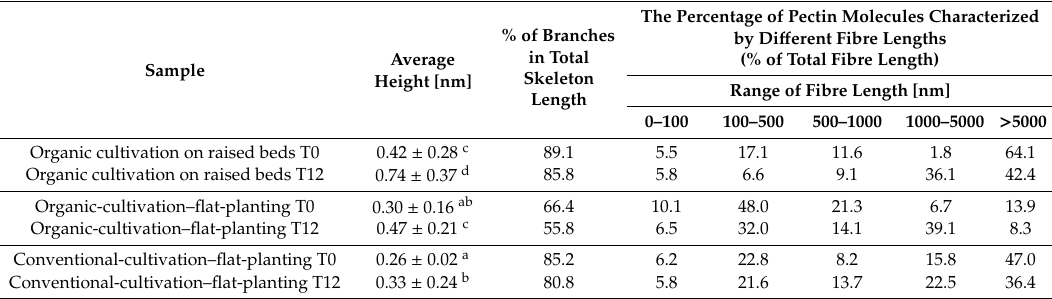
Table 4. Topographic parameters of pectin molecules extracted from fresh (T0) and stored (T12) strawberries with ammonium oxalate.